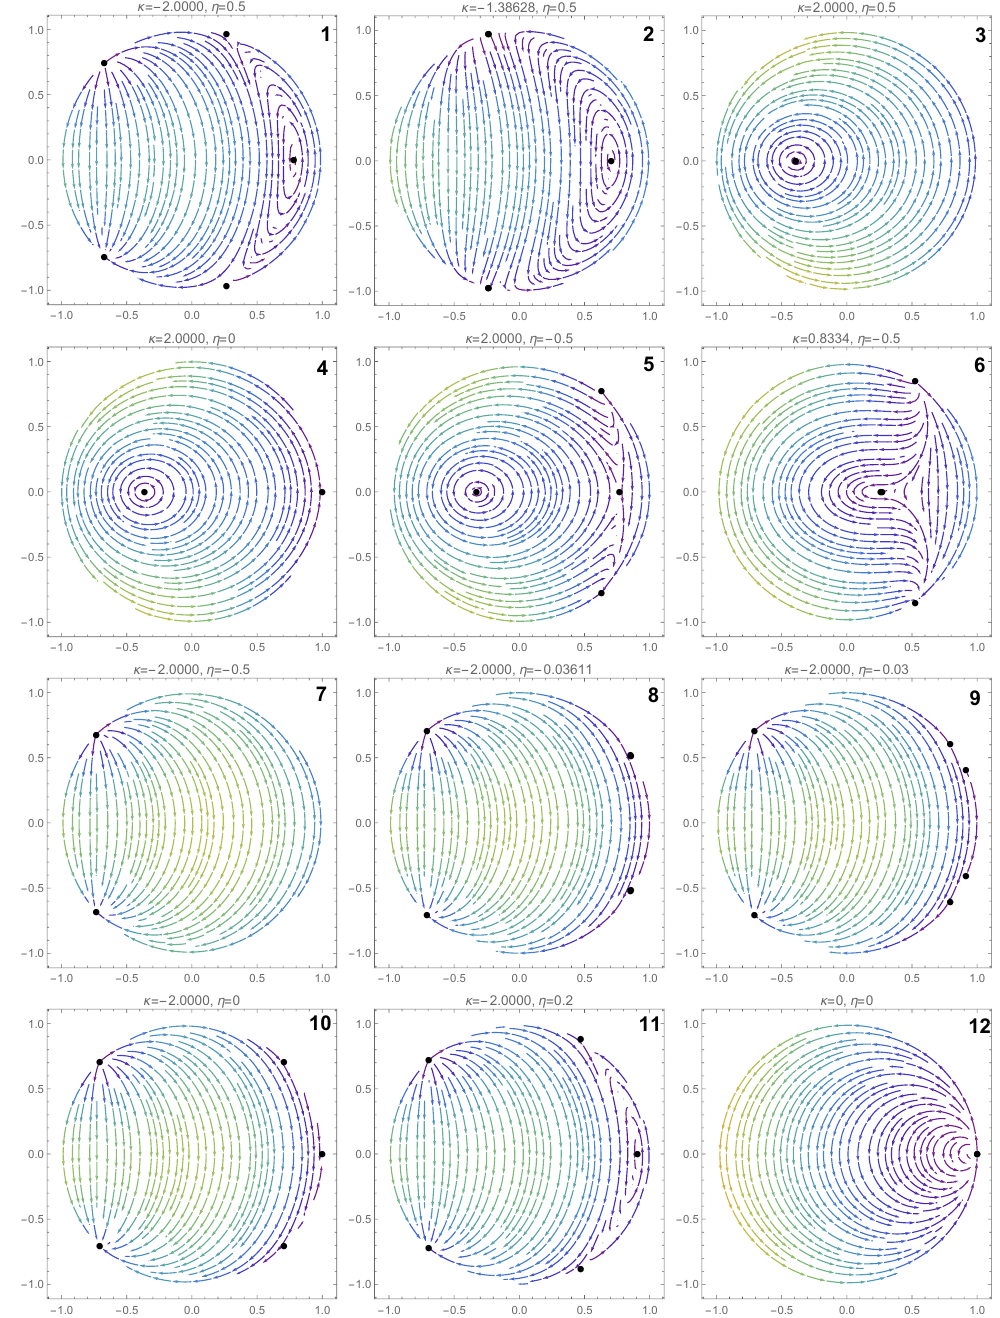
Figure 3. Phase portraits of system (7) and (8) for values of the parameters ( κ , η ) on the sides of the dashed rectangle shown in Figure 2 (panels 1–11) and for ( κ , η ) = ( 0,0 ) (panel 12). The type of the equilibrium points (solid black dots) and the bifurcations that occur are discussed in detail in Section 3. Crossing from the yellow region to the green region of Figure 2 via the curve ( c ) , a saddle-center bifurcation takes place (see panel 6 in Figure 3), where the type 2 equilibria (a saddle and a center) collide and disappear. When ( κ , η ) belong to the green region of Figure 2 (see panel 7 in Figure 3), only one pair of type 1 equilibria exists (a source and a sink). In this case, the region of attraction of the sink is the whole unit disk with the unstable equilibrium point (source)